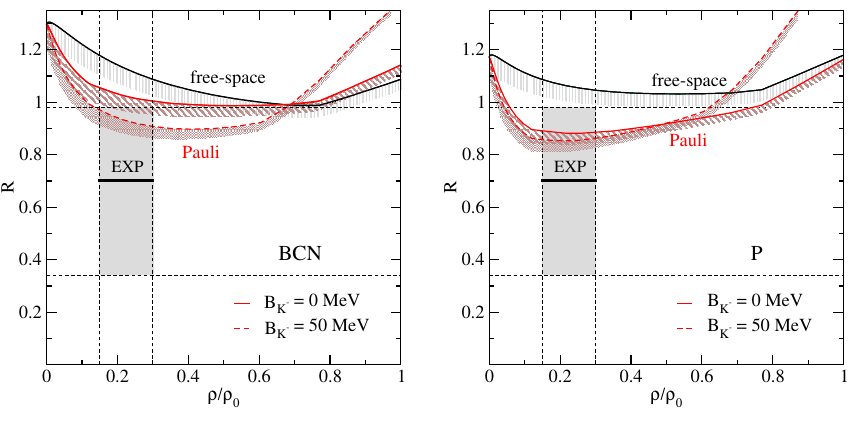
Figure 3. The ratio R as a function of relative density, calculated using the free-space and Pauli blocked amplitudes for B K − = 0 MeV and B K − = 50 MeV. Color bands denote the uncertainty due to di ff erent cut-o ff values Λ c = 800 − 1200 MeV. Figure adapted from Ref.